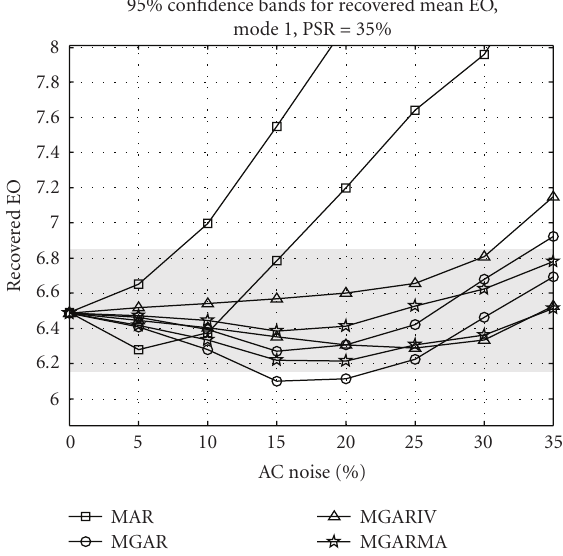
Figure 8: Test 2: 95% confidence bands for Prony-based methods, mode 1.